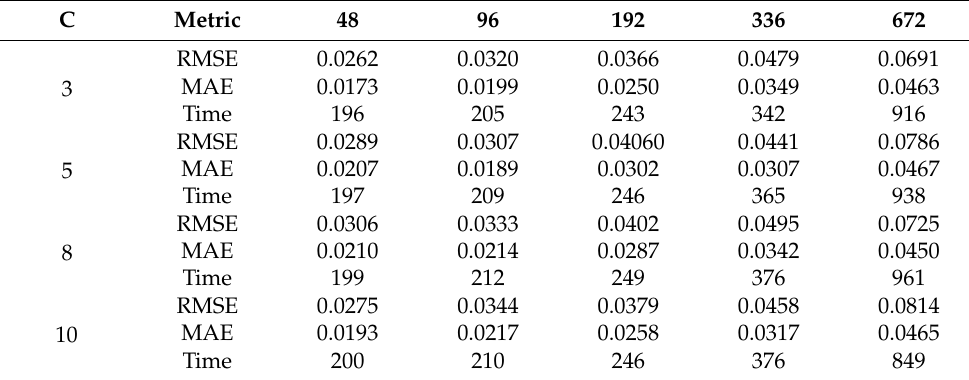
Table 4. Influence of different C values on model